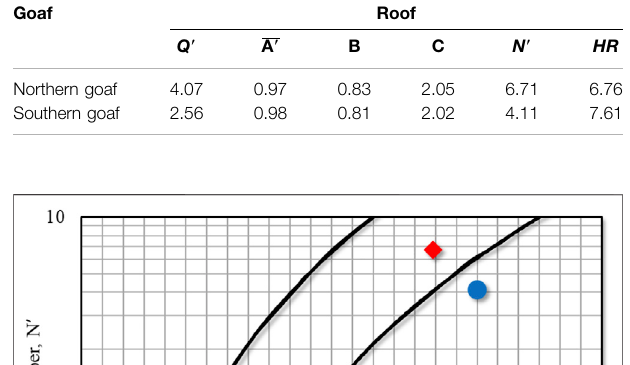
TABLE 3 | Calculation of stability number N in each goaf.